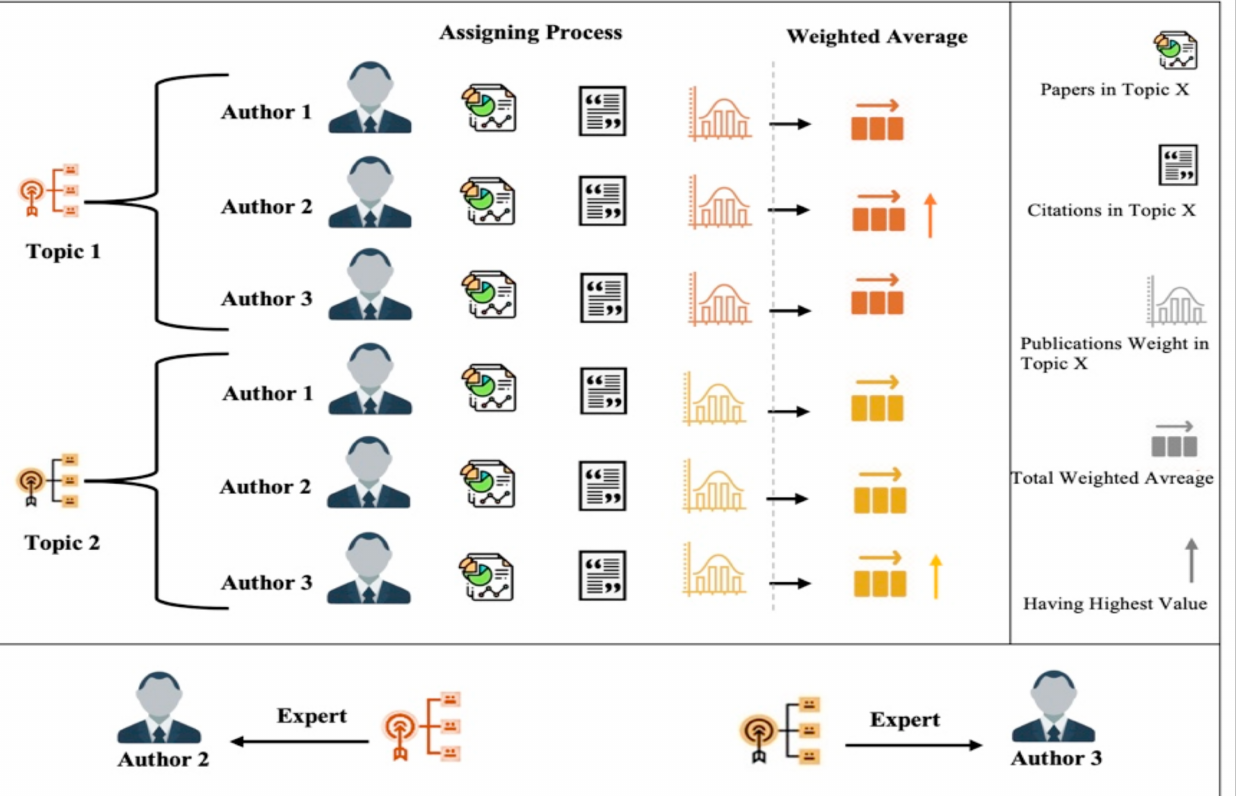
Figure 6. The process of extracting